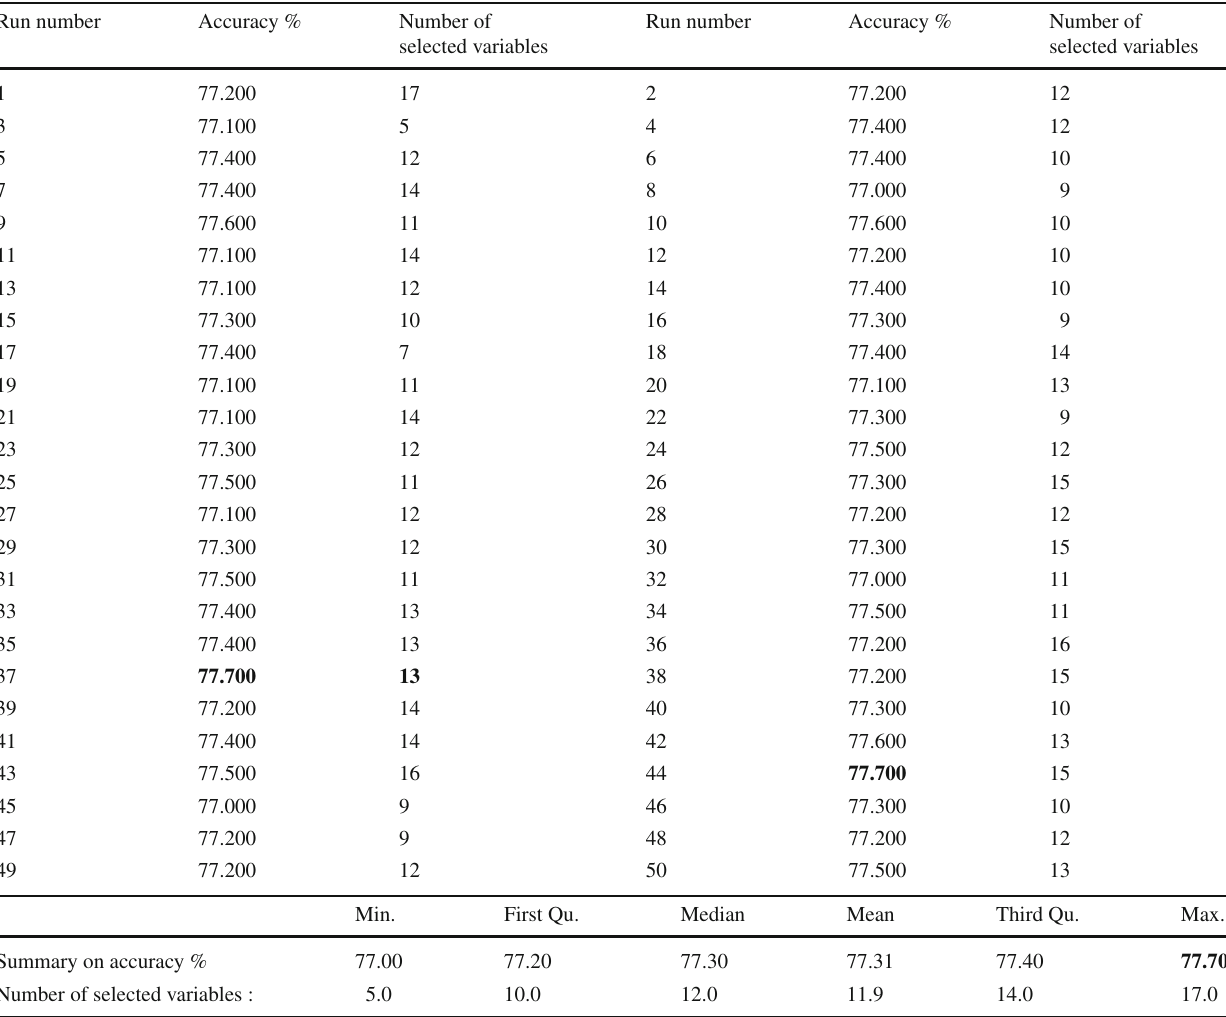
Table 3 The results of 50 run of LS+SVM on German